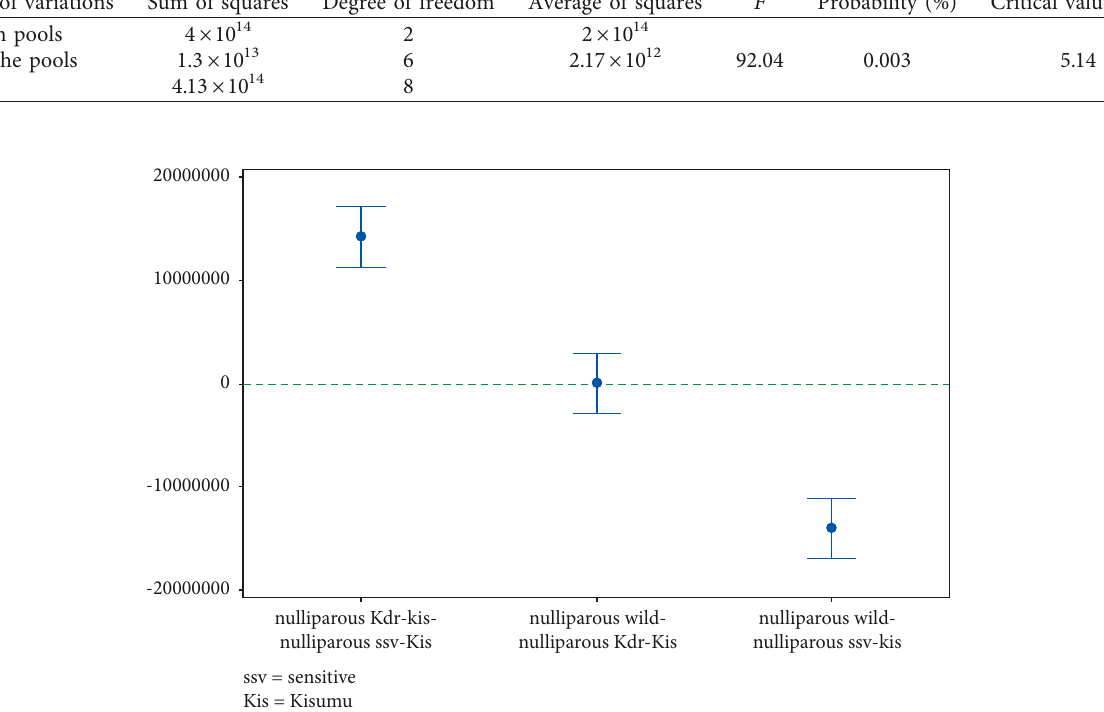
Figure 5: Graph of Fisher’s test results for nulliparous mosquitoes.